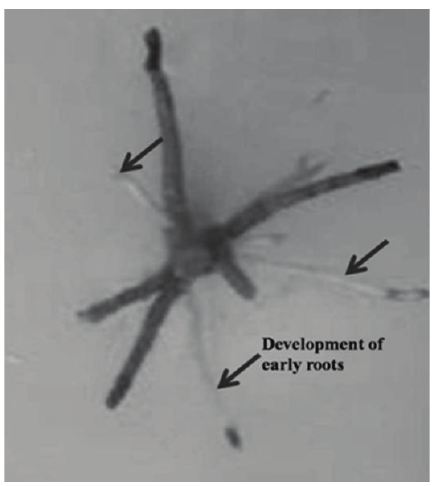
Figure 8: Development of early roots in S. aquimarina SjAM16103 inoculated explants of E . agallocha ( in vitro ).